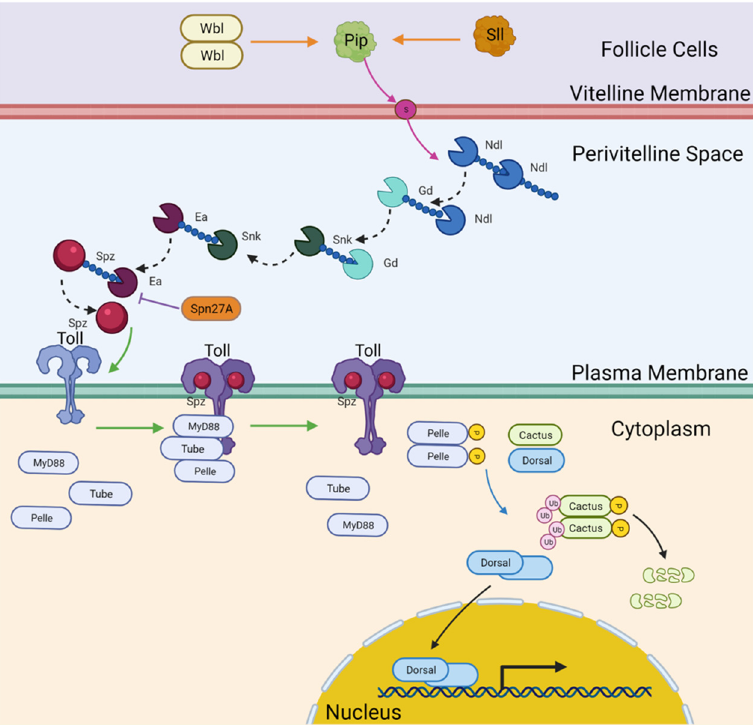
Figure 1. Summary of the components of the Drosophila Toll pathway used for comparison here. Created with BioRender.com.